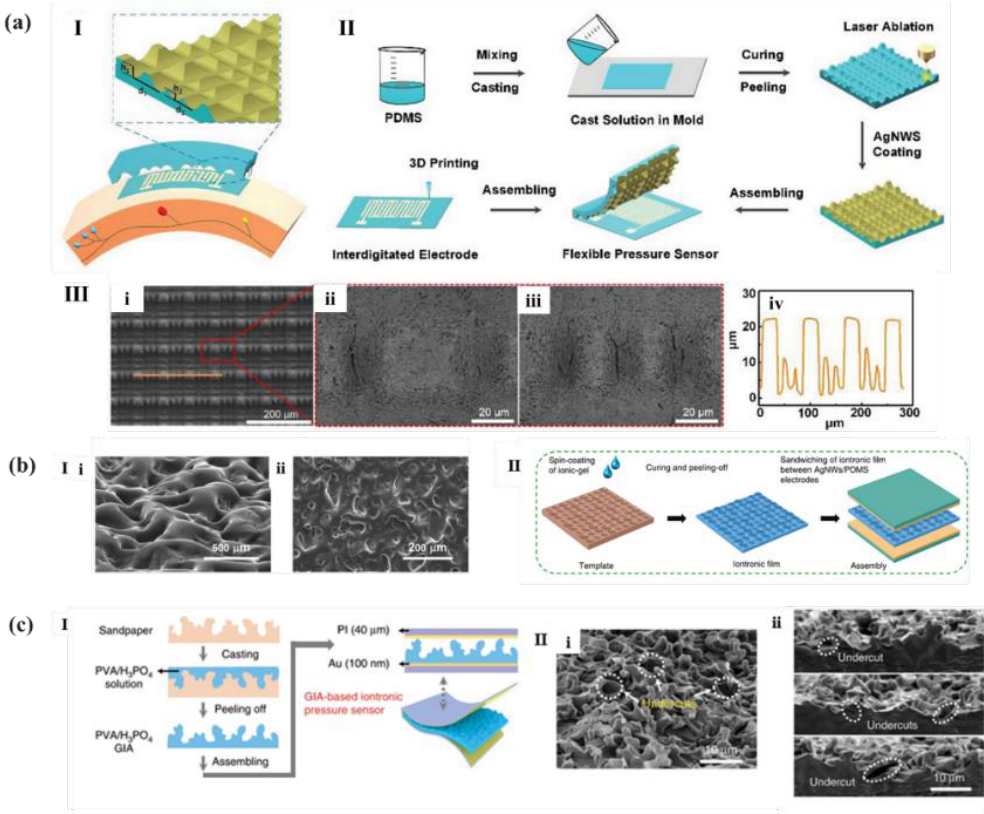
Figure 10. ( a , I ) Schematic illustration of the flexible pressure sensor; ( II ) The fabrication process of flexible pressure sensor; ( III ) SEM images of laser scribed PDMS surface [84]. ( b , I ) The FESEM images of the inclined view ( i ) and top view ( ii ) of the microstructured iontronic film; ( II ) A schematic of the fabrication sequence [86]. ( c , I ) Schematic illustration of the preparation of a GIA-based iontronic pressure sensor; ( II ) A 45° tilt-view ( i ) and cross-sectional ( ii ) view SEM images of the film [87].